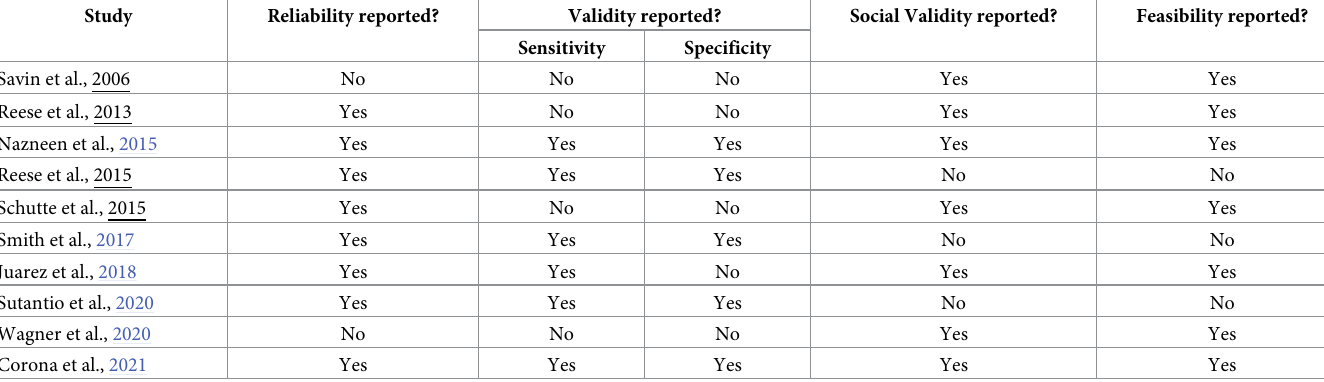
Table 4. Outcomes of included